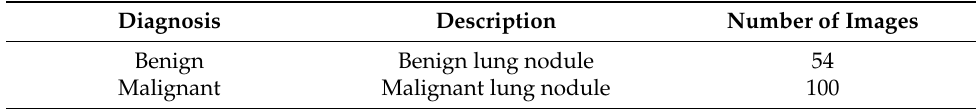
Table 5. JSRT patient level diagnosis metadata